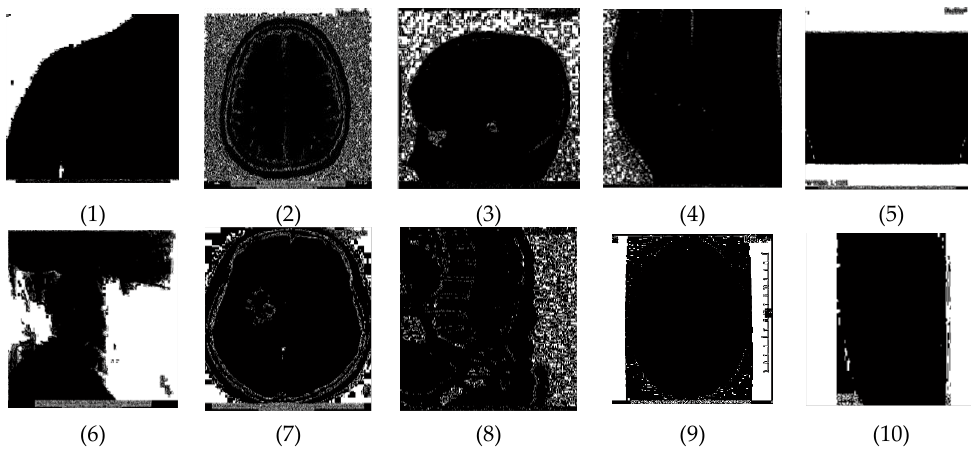
Figure 4. Intensity based classification of images of Figure 2.